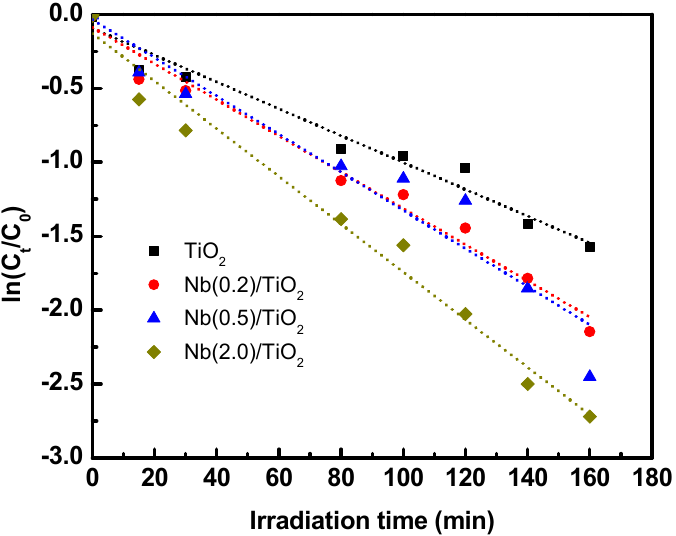
Figure 9. Semi-logarithmic graph of phenol red concentration of 20 mg/L as a function of the irradiation time on the surface of TiO 2 , Nb(0.2)/TiO 2 , Nb(0.5)/TiO 2 , and Nb(2.0)/TiO 2 . The instantaneous amount or quantity ( 𝑞 (cid:3047) ) of degraded dye as a function of irradiation time is estimated by Equation (12) [38]: (𝐶 (cid:2868) − 𝐶 (cid:3047) ) 𝑞 (cid:3047) = 𝑉 (12) 𝑚 where 𝐶 (cid:3047) is the instant phenol red concentration. The amount of degraded phenol red as a function of irradiation time is shown in Figure 10, which indicates the adsorption capacity dependence. The adsorption capacity was improved with increasing the time, as with the photocatalysis efficiency curve observed in Figure 8. The capacity of the Nb(2.0)/TiO 2 nanocomposite is higher than the others.